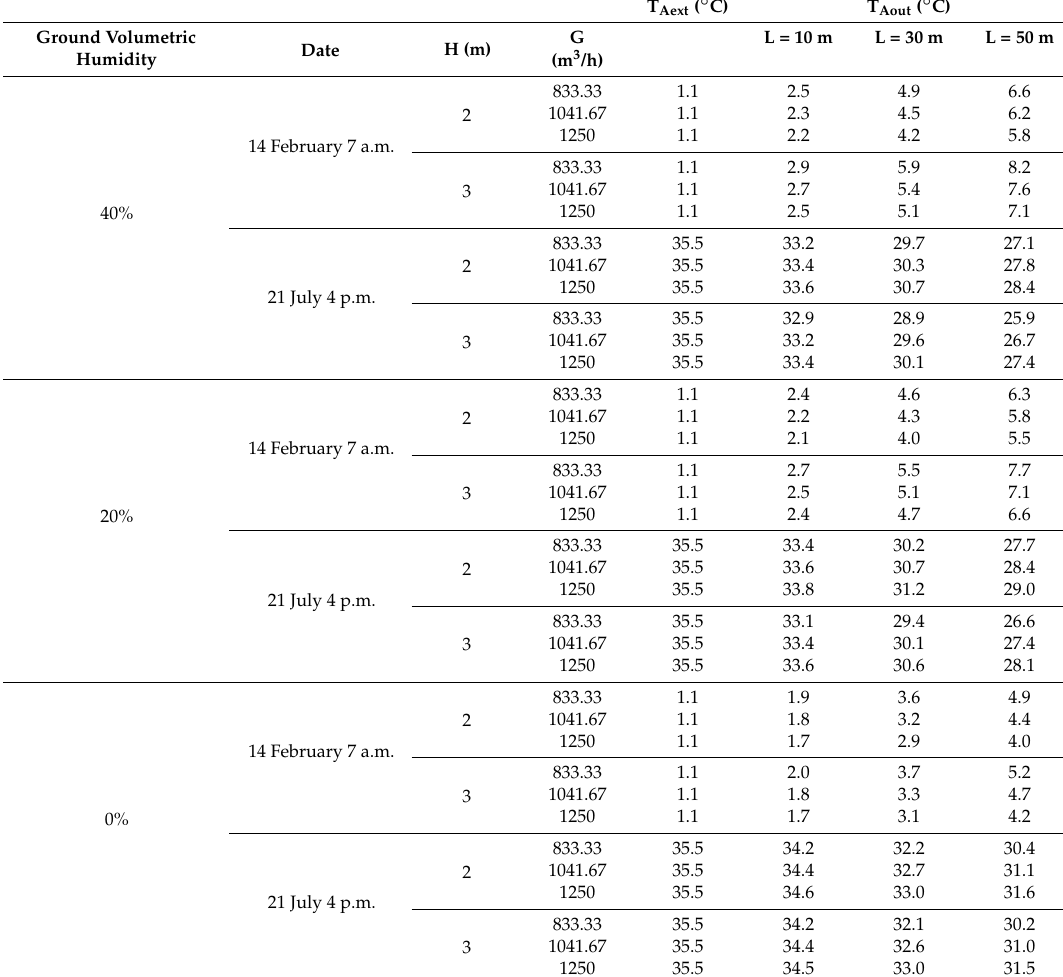
Table 4. External air temperatures ( ◦ C) and treated air temperatures outgoing from HAGHE.